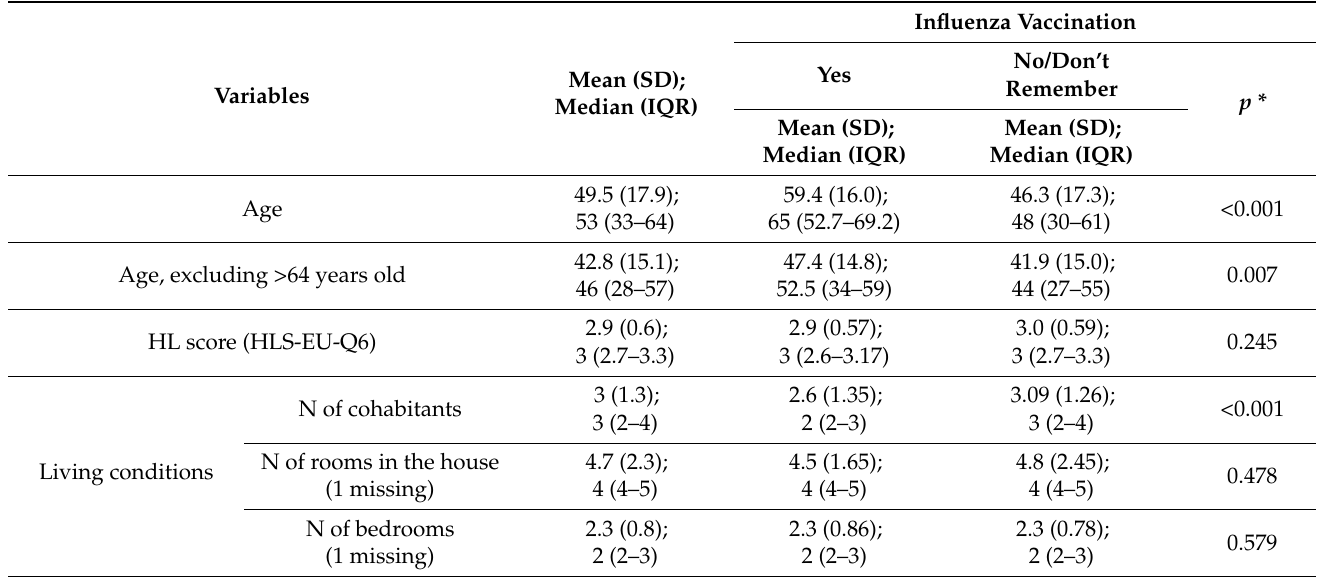
Table 2. Descriptive analysis of the numerical variables for the whole sample and by